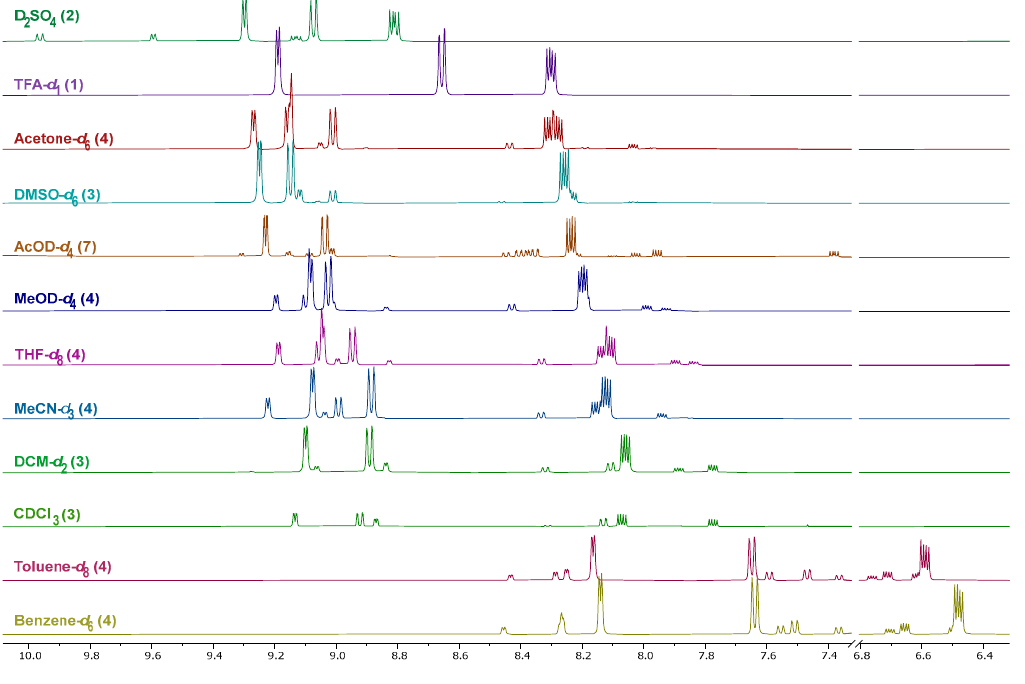
Figure 3. 1 H-NMR spectra of diazide 2 in various solvents (number of the observed tautomers reported in parentheses).